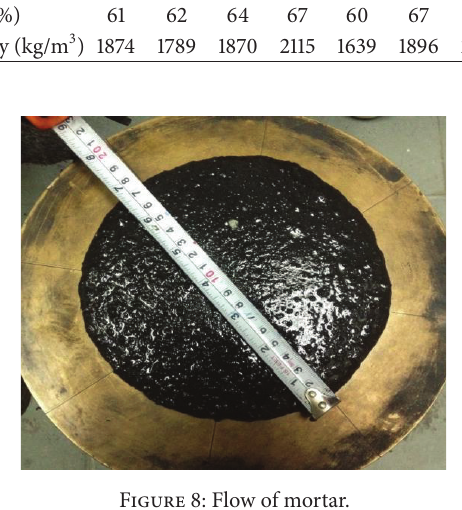
Figure 8: Flow of mortar.